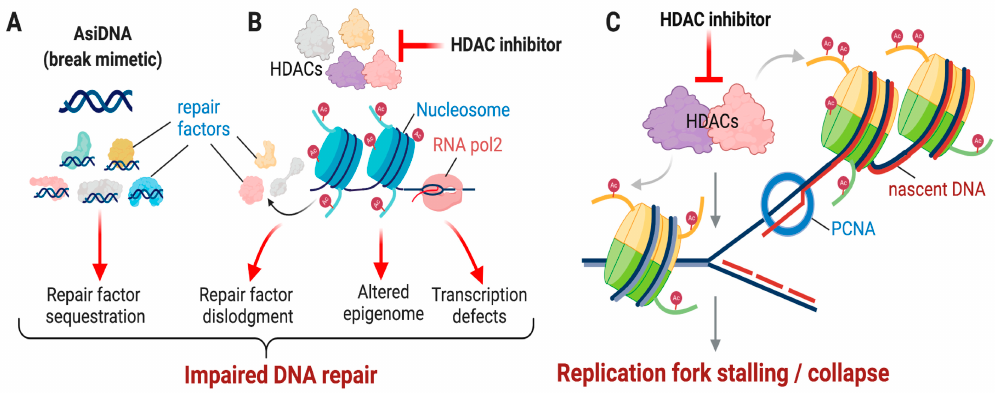
Figure 1. Mechanisms by which AsiDNA treatment and histone deacetylase (HDAC) inhibition alter genome stability during repair and replication in cancer cells. ( A ) AsiDNA acts as a DNA mimetic to sequester DNA repair factors. ( B ) Multiple ways by which HDAC inhibition can impair DNA repair. Stalled transcribing RNA polymerase II (pol2) and resulting RNA-DNA hybrid or R-loop are shown. ( C ) Replication defects caused by HDAC inhibition. Newly replicated or nascent DNA in leading or lagging strand is shown in maroon, and the non-replicated or old DNA is shown in light blue.